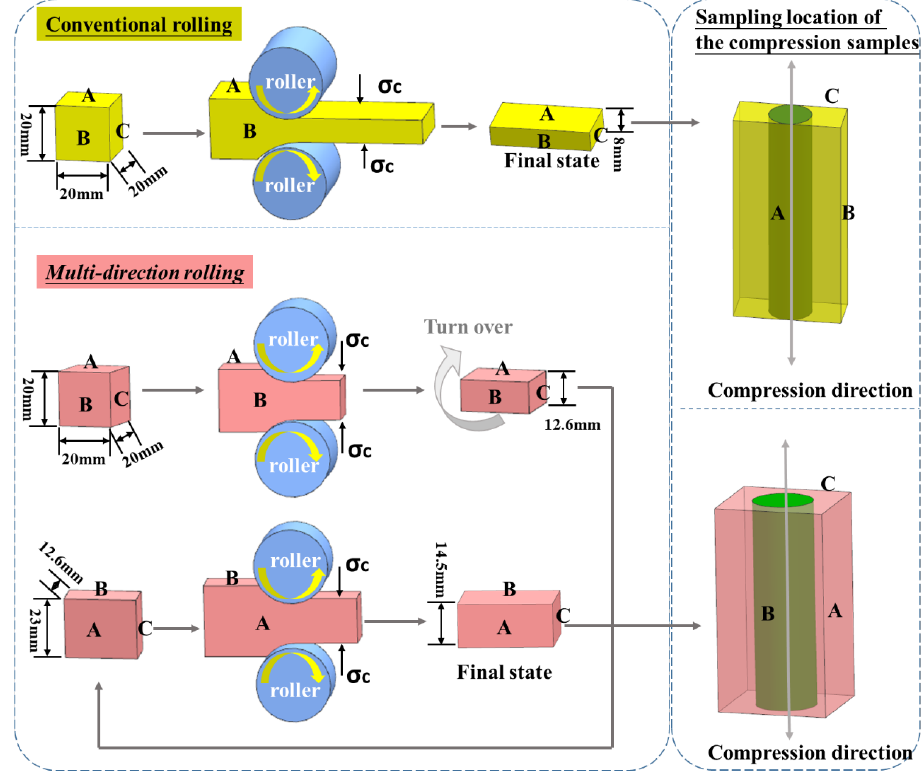
Figure 1. Schematic diagram of rolling and the positions of compression samples in as-rolled samples.